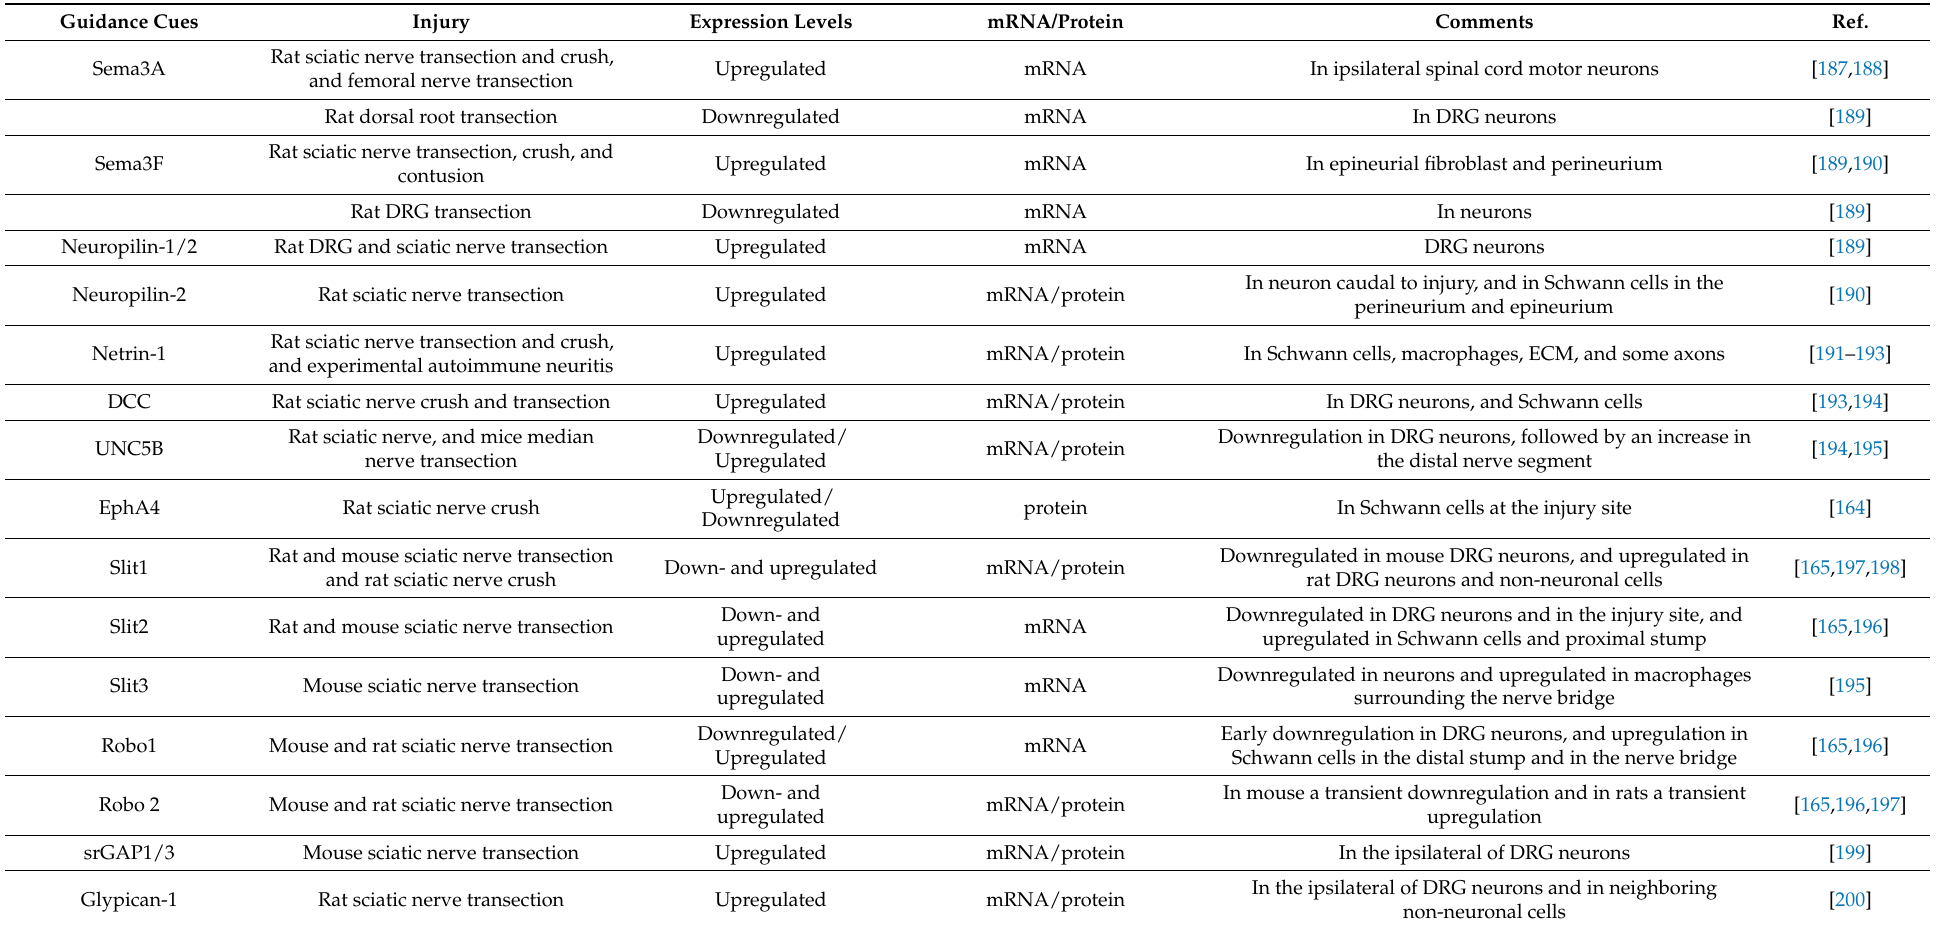
Table 2. Differential expression of guidance cues after different PNS injury